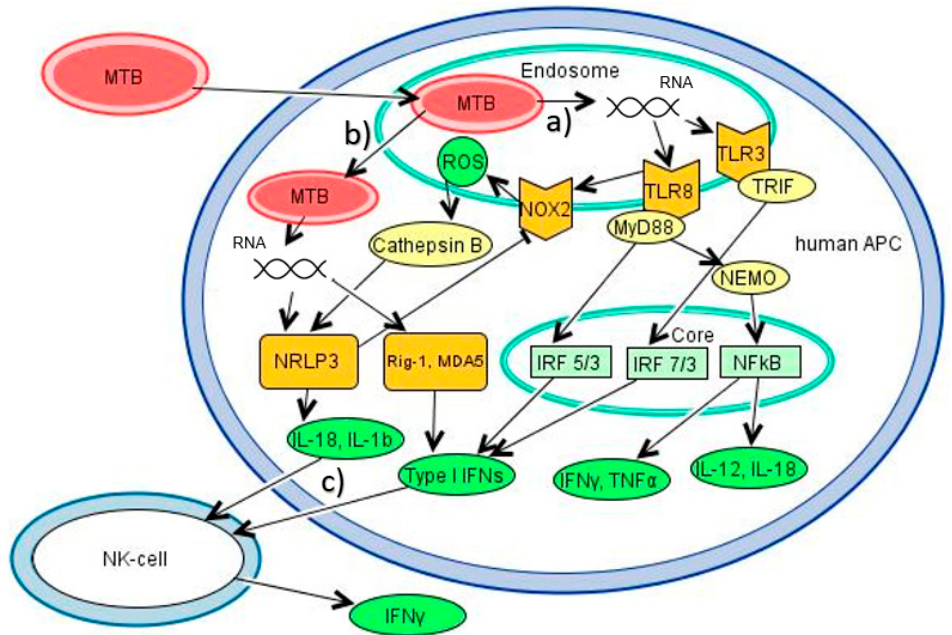
Figure 1. Main immunological pathways in human antigen presenting cells (APCs) after mycobacterial RNA recognition. ( a ) Mycobacteria are engulfed into phagosomes of macrophages and APCs, where RNA is released, eventually stimulating the endosomal receptors TLR8 (ssRNA) and -3 (dsRNA). Activated TLR8 with its adaptor protein MyD88 induces a signal transduction cascade including NF-kappa-B essential modulator (NEMO) ultimately leading to the translocation of NF- κ B into the nucleus. Furthermore, mainly interferon response factor (IRF)-5 and to a minor part IRF-7 translocate into the nucleus and activate genes. TLR3 with the adapter protein TRIF leads to translocation of IRF-3 and -7 into the nucleus. NF κ B promotes the synthesis of IL-18, IL-12, IFN γ and TNF α , while IRFs promote the production of type I interferons, which activate natural killer (NK) cells to further promote IFN γ in the sense of a feed-forward loop [23]. At the same time, activation of TLR8 enhances production of reactive oxygen species (ROS) through activation of Cytochrome b (-245) beta (CYBB) / NADPH oxidase 2 (NOX2), which will themselves activate the canonical inflammation pathway through Cathepsin B translocating to the cytosol [52,73]. ( b ) After transition to the cytosol, mycobacterial RNA stimulates NLRP3 of the inflammasome, which lead to caspase-1 dependent production of IL-18, IL-1 β and pyroptosis [50,51], as well as the RLRs Rig-1 and MDA5, leading to expression of type I IFNs [60]. These cytokines will again stimulate NK cells to produce IFN γ . ( c ) Simultaneously, activation of NLRP3 inhibits CYBB / NOX2 in the sense of a negative-feedback loop [75].